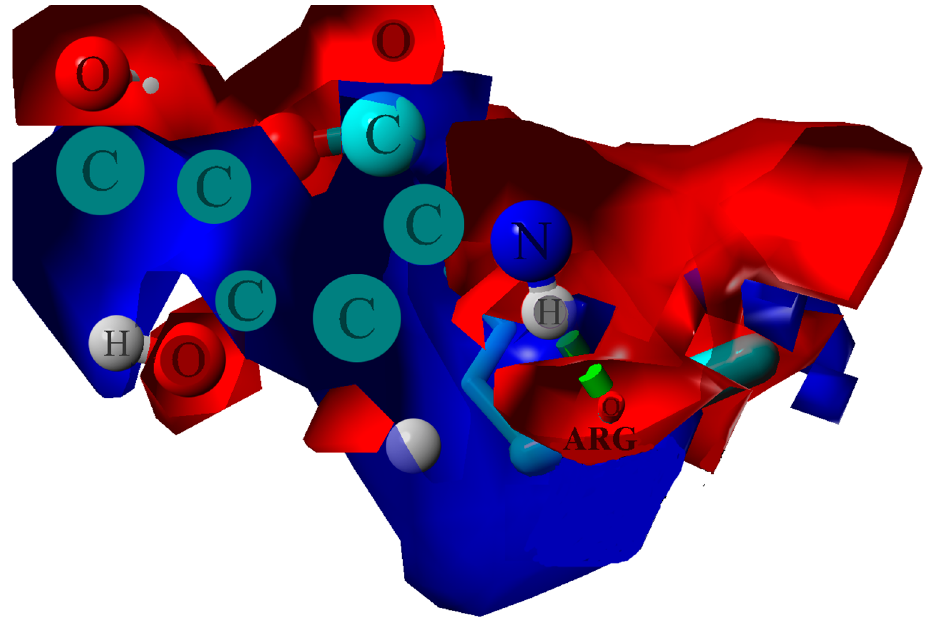
Figure 7. Electrostatic potential map determined for ARG–chitosan (DD = 87.5%) contact. The blue color stands for the positive charge, and the red denotes the negative charge. The green dotted line indicates H-bond.